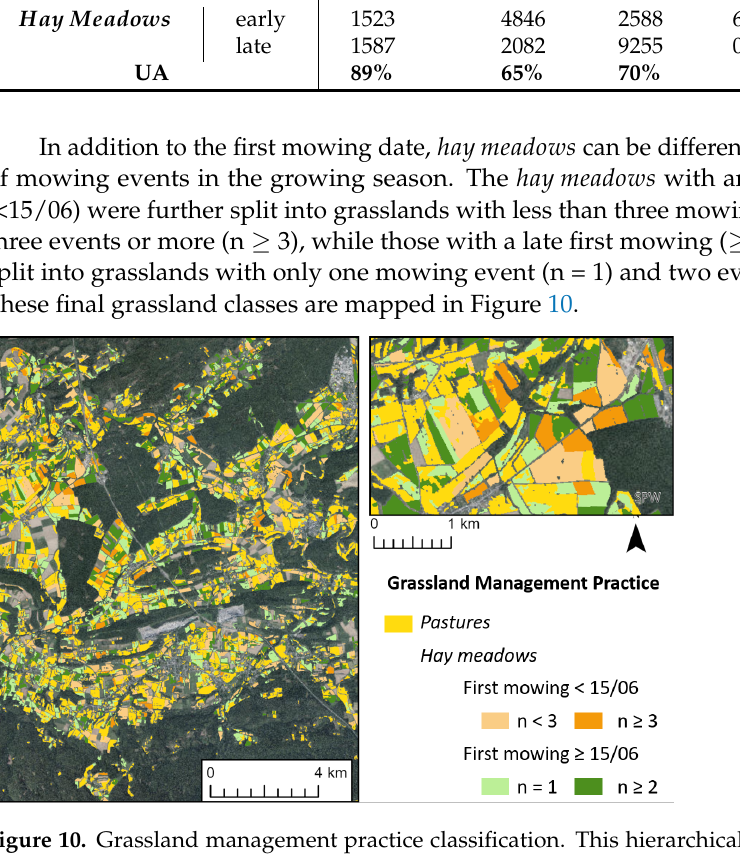
Table 7. Validation of the hierarchical grassland typology. Confusion matrices crossing the main management practice classes ( pastures and hay meadows ) and the first mowing event classes (before (early) or after June 15th (late)) based on field observations (ref) and on the classification and mowing detection (pred). The user and producer accuracies (UA and PA) are provided as well as the overall accuracy (OA). Hay Meadows Ref\Pred